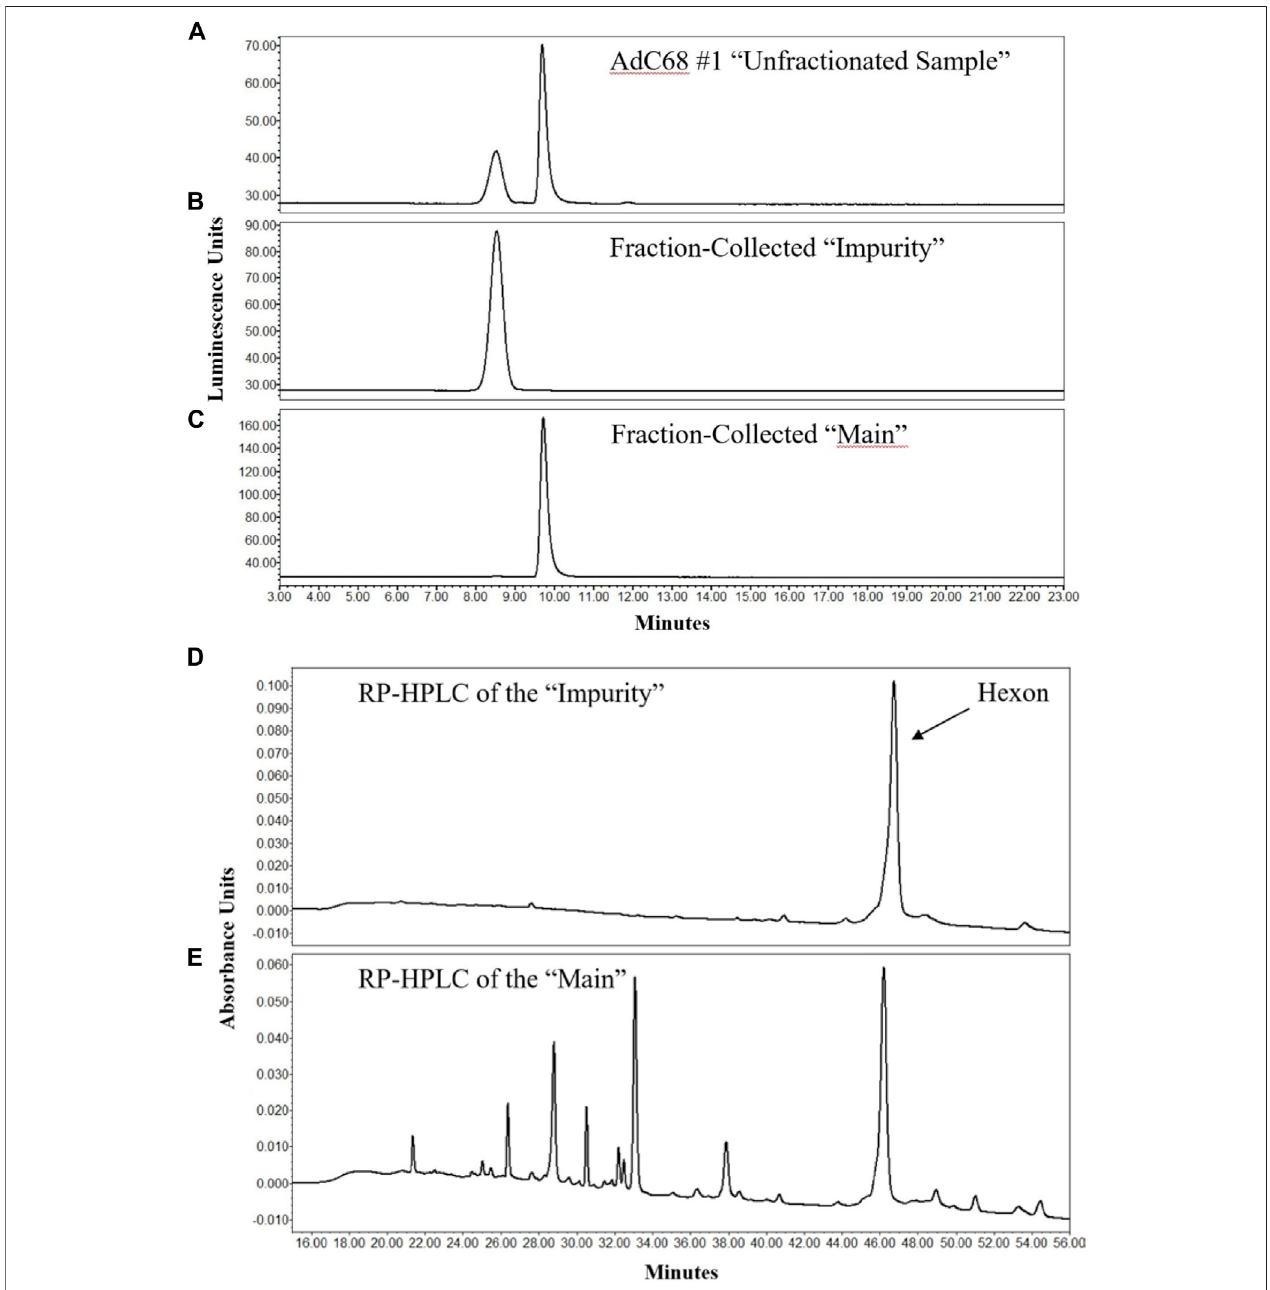
FIGURE 2 | AEX-HPLC and RP-HPLC pro fi les of the 12-weeks accelerated stability sample. The chromatographic pro fi le of the unfractionated 12-weeks stability sampleisshownin (A) .Afterenrichmentofthe “ Impurity ” and “ Main ” peaksbythepreparativeAEX-HPLCassay,ef fi cientenrichmentwasdemonstratedofthe “ Impurity ” (B) and “ Main ” (C) peaks by the analytical AEX-HPLC method. Analyses of fractionated “ Impurity ” and “ Main ” peaks by RP-HPLC are shown in (D,E) ,